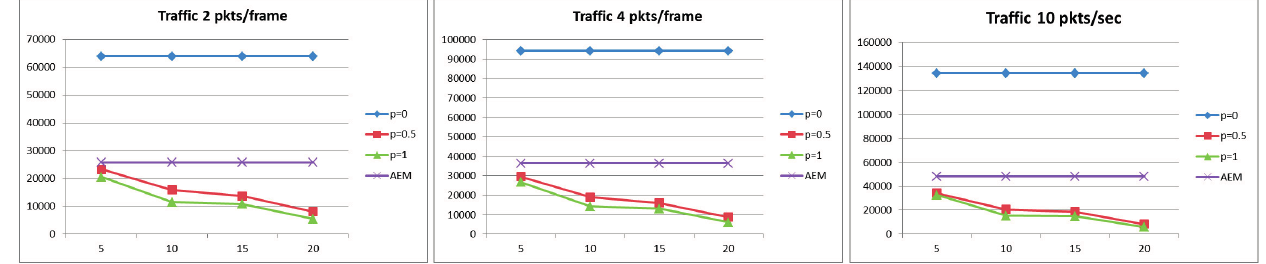
Figure 5. Energy Consumption for D = 20 s.